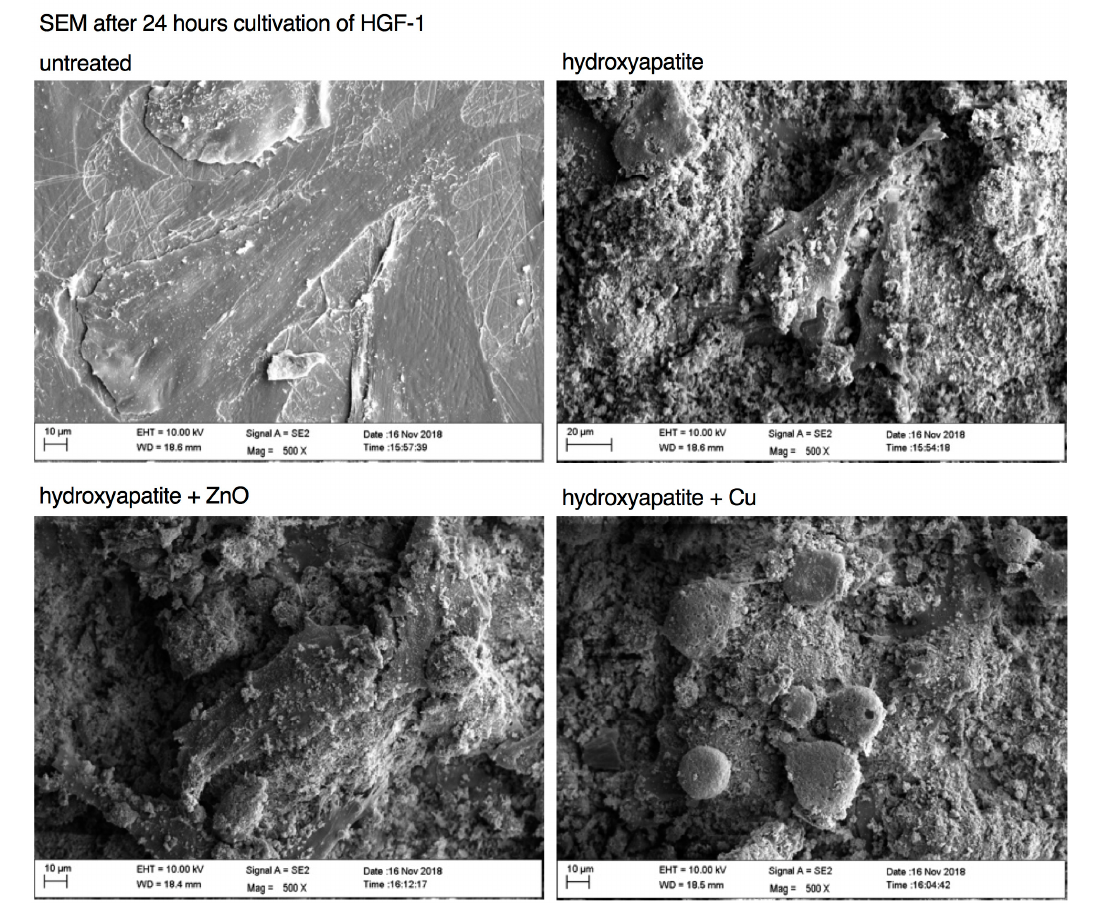
Figure 4. Representative SEM images of the specimens with attached HGF-1 cells at 500× magnifi- cation. UL: untreated; UR: coated with hydroxyapatite; LL: coated with hydroxyapatite +ZnO; LR: coated with hydroxyapatite + Cu.